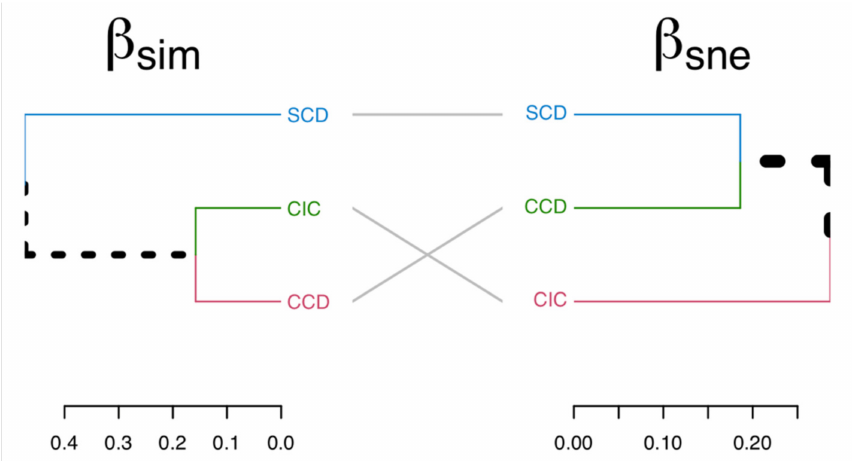
Figure 7. Beta diversity ( β sim and β sne) among three plant communities of pure Deodar forest. (For the complete names of plant communities, see Figure